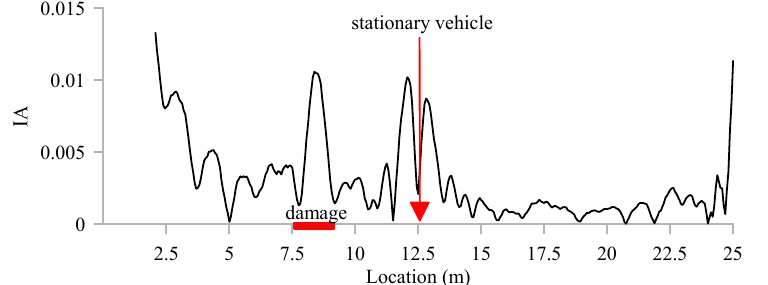
Figure 9. IA of the IMF of contact-point response of the damped stationary vehicle.